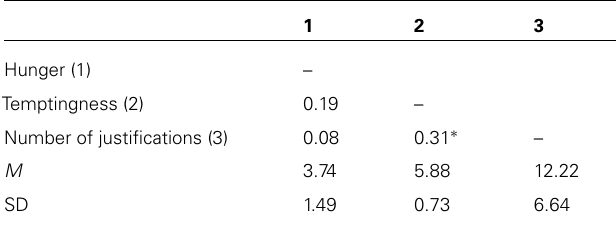
Table 1 | Means, SDs, and Correlations (Study 1).